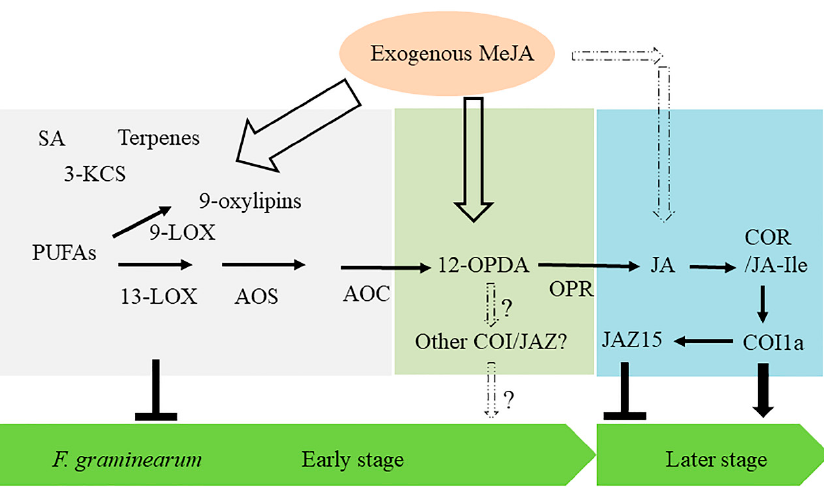
Figure 7. Working model of ZmCOIa-ZmJAZ15 function module in the immunity to GSR. The filled arrows indicate the activation of signaling components by MeJA treatment in JA pathways, and the dashed open arrows indicate to-be-verified activation by exogenous MeJA treatment. The wider the arrows, the stronger the effects. The solid black arrows and bars represent the positive and negative role in disease development, respectively.